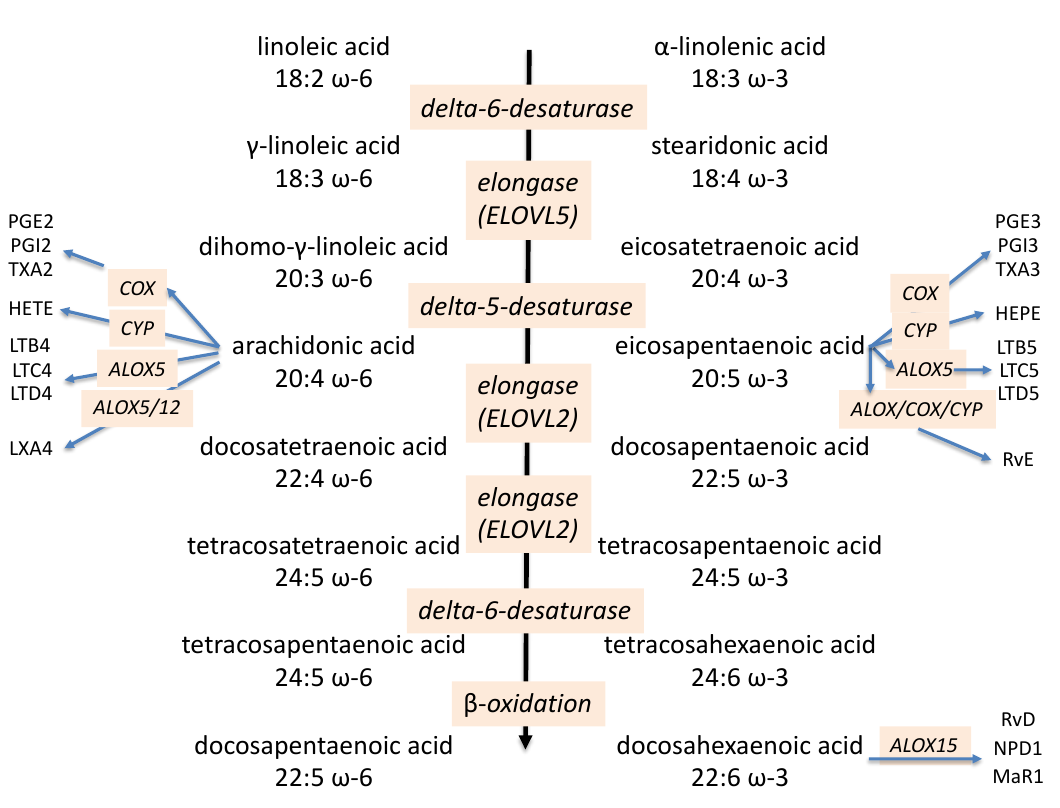
Figure 1. Omega-3/omega-6 PUFA pathways and their bioactive lipid metabolites.